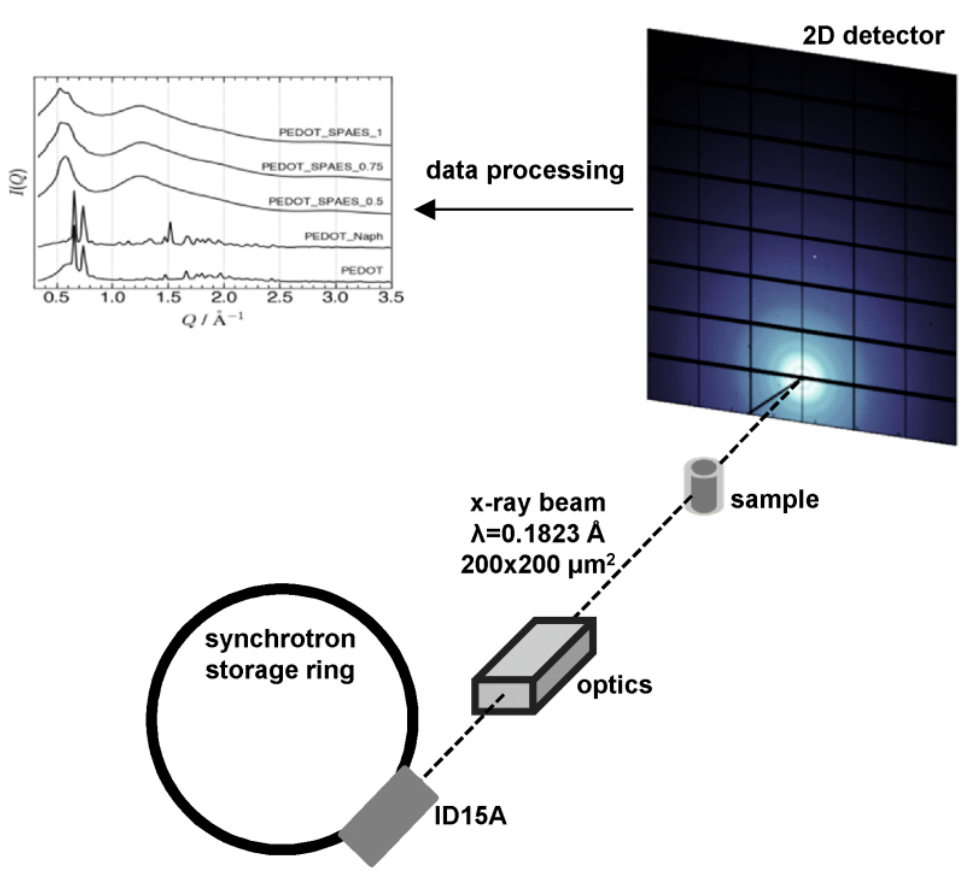
Figure A1. Schematic of the high-energy X-ray diffraction setup. Data processing to obtain one-dimensional data is outlined in the Experimental section of the main manuscript.